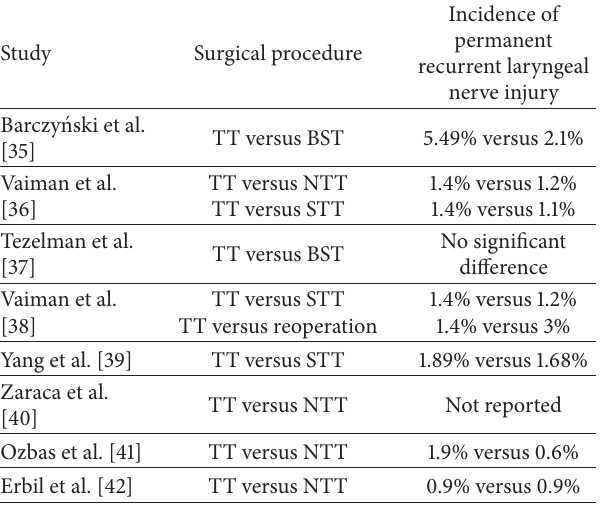
Table 1: Incidence of recurrent laryngeal nerve injury in various thyroid